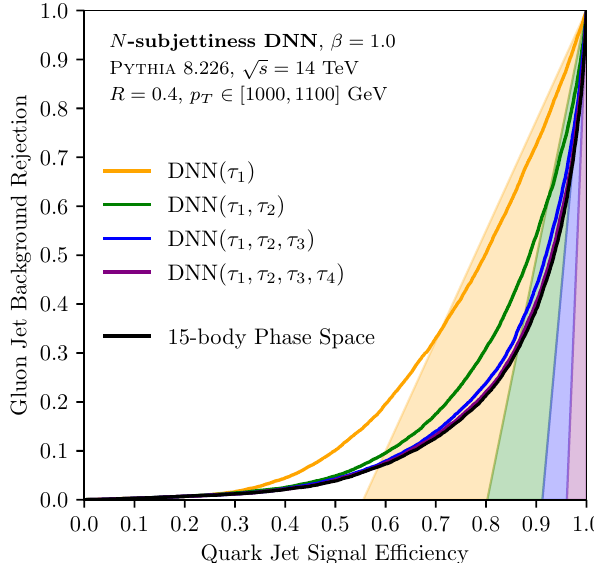
Figure 16. The ROC curves for neural networks combining N -subjettiness observables with (cid:12) = 1, together with the predictions for their asymptotic behavior in the high quark e(cid:14)ciency region based on (cid:20) g = ( C F =C A ) N . The classi(cid:12)cation performance increases as N -subjettiness observables are added, saturating at the performance of using 15-body phase space. The asymptotic classi(cid:12)cation performance is qualitatively well described by the analytical estimates via reducibility factors for N -emission sensitive